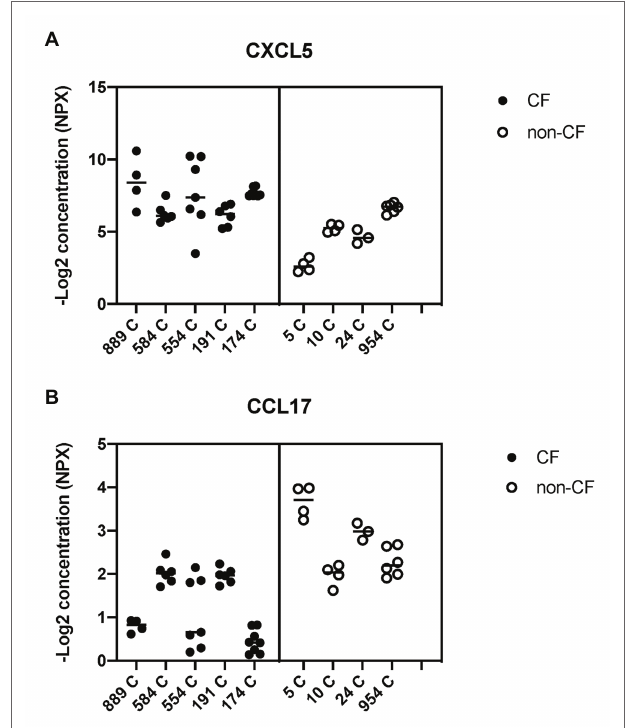
FIGURE 8 | Basal shedding of cytokines and growth factors by primary CF and non-CF airway epithelial cells. Markers of inflammation and tissue remodeling were measured by a Fluidigm-based protein array (Olink 96×96 Oncology/inflammation) in basal medium (BEGM minus EGF), 24 h after the medium change. CF HBEC-ALI (five donors, Table 1 , 31 samples) compared to non-CF (WT) cultured in parallel (four donors, 17 samples). Complete array data are summarized in Supplementary Table S1 . Data are expressed as NPX ( − Log2 expression relative to the internal control). (A) CXCL5 (C-X-C chemokine ligand 5) involved in neutrophil activation and angiogenesis is on average four-fold (two logs) higher in CF media compared to non-CF. (B) CCL17 (C-C motif chemokine ligand 17) involved in trafficking and maturation of T-cells is four-fold lower in CF HBEC [statistical analysis on